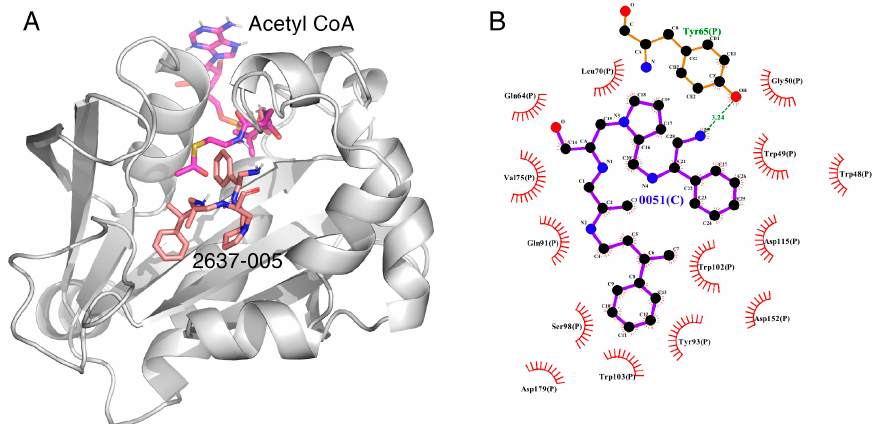
Figure 3. ( A ) The complex of 2637.005 and AAC(6 (cid:48) )-Ib obtained from molecular docking. The bound acetyl CoA is also shown. ( B ) Interaction map of the ligand in its binding site of the AAC(6 (cid:48) )-Ib receptor. Compound 2637.005 adopts a different orientation in the pocket and now the primary amine interacts with the phenol group of Tyr65 and the hydroxyl group is no longer close enough to hydrogen bond with Gln64. The pictures show the top-ranked, lowest-energy